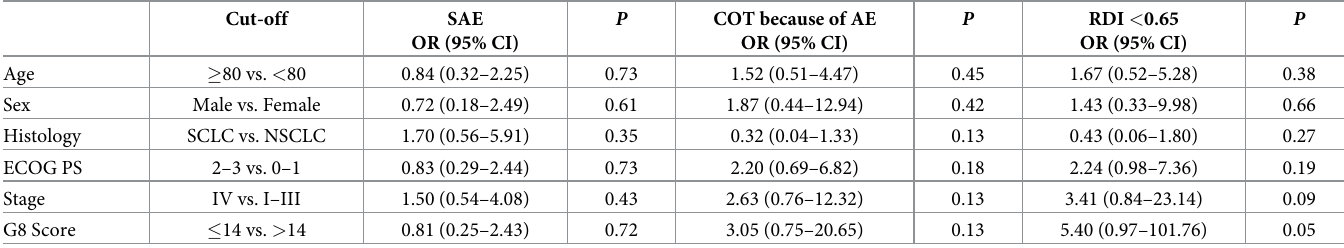
Table 4. Prognostic value of G8 and other patient characteristics in the patients treated with chemotherapy (n = 76).